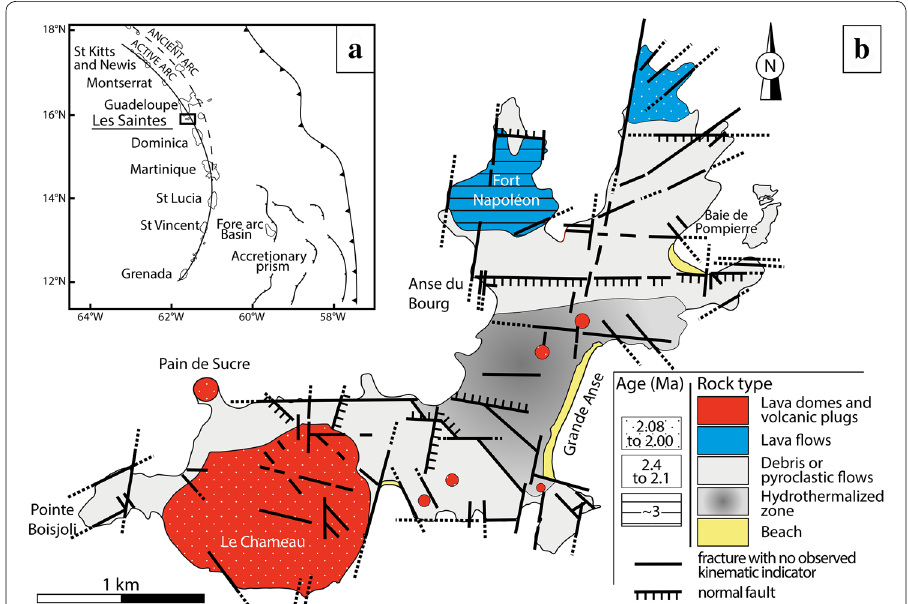
Fig. 1 a Simplified geodynamic map of the Lesser Antilles Arc. b Simplified geological map of Terre-de-Haut (Les Saintes archipelago) indicating structural data, volcanic rock types and their ages (modified after Verati et al. 2016; Zami et al. 2014; Jacques and Maury 1988a, b; Jacques et al. 1984). Symbols refer to age of the rock formation, whereas colours refer to rock type. Note the orientation of the faults and